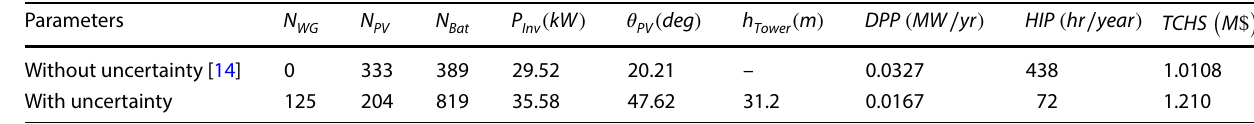
With uncertainty